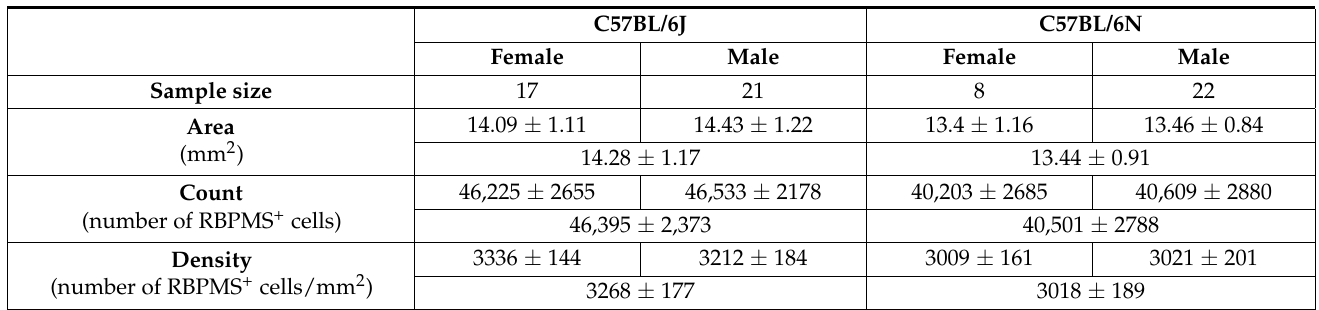
Table 1. Overview of retinal area, global RGC count and -density for C57BL/6J and -N mice, per sex and in total (sex-mixed). Values were calculated using the automated tool RGCode and are reported as mean ± SD.